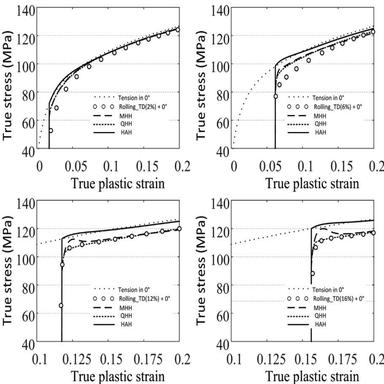
Experimental and simulated (with the HAH model) maximum stress ratio for tension-tension tests at various angles from the RD.